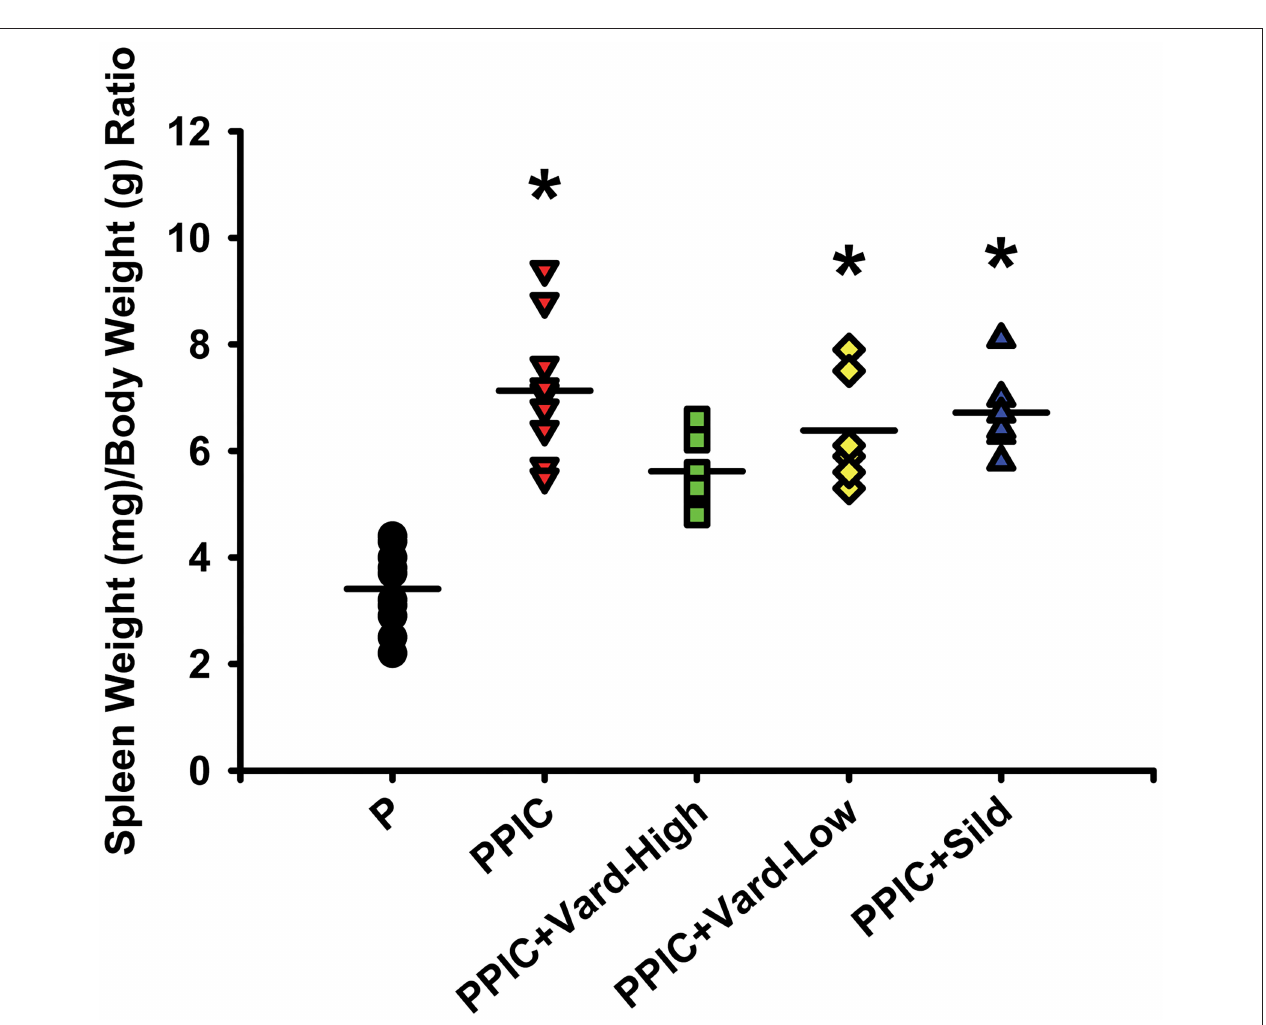
FIGURE 3 | Spleen weight to body weight ratios of control pregnant (P) mice ( n = 10), P mice treated with the TLR3 agonist and viral mimetic poly I:C (PPIC) ( n = 10), PPIC mice treated with a high dose ( n = 6) and low dose ( n = 6) of vardenafil (Vard), and PPIC mice treated with sildenafil (Sild) ( n = 6). * p < 0.05 by ANOVA compared to P